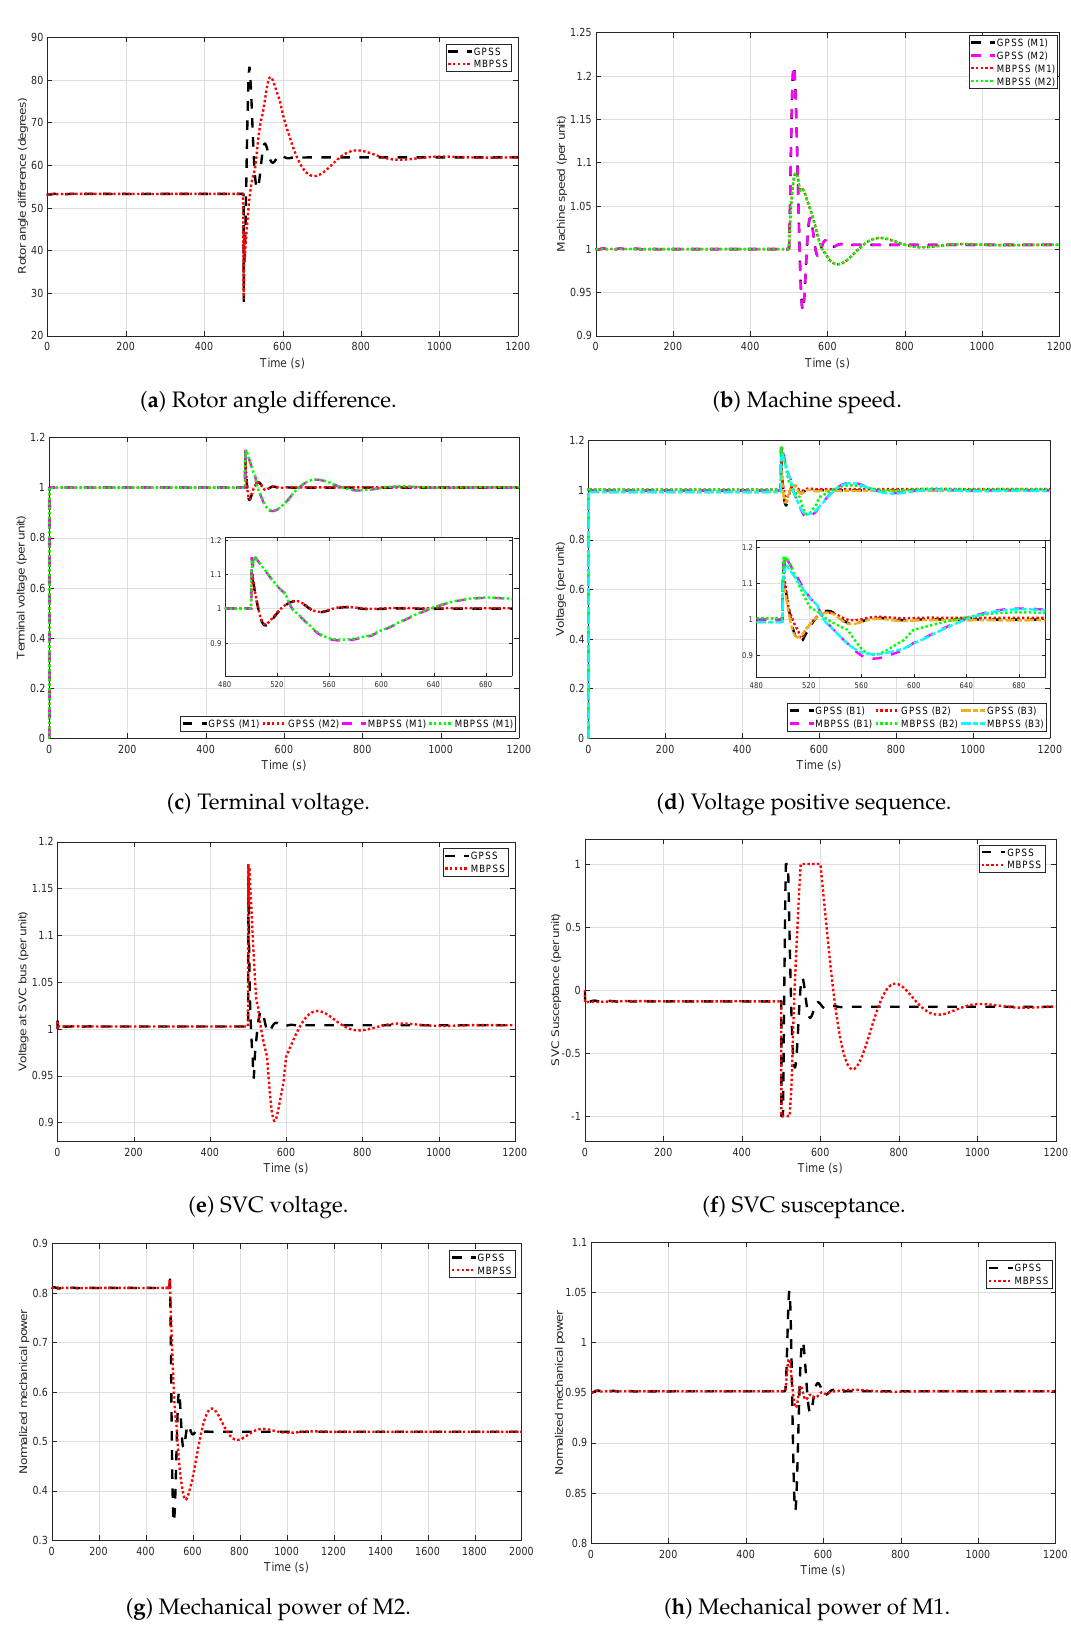
Figure 14. Case III.1: Variation in network signals during permanent load loss with generic and multiband PSS with